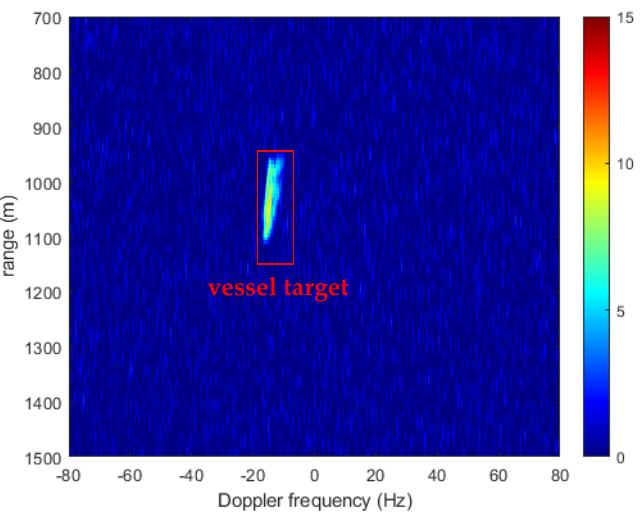
Figure 7. The long-time integration results in RD domain using the existing method.